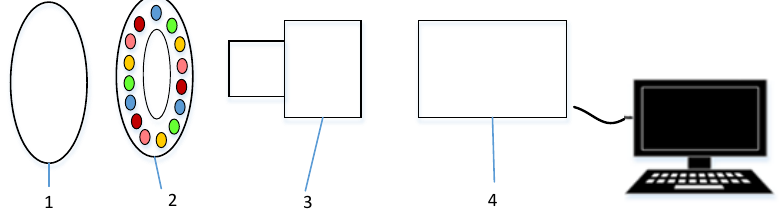
Figure 1. Hardware structure (1) diffuser, (2) LED ring, (3) RGB camera, (4) control